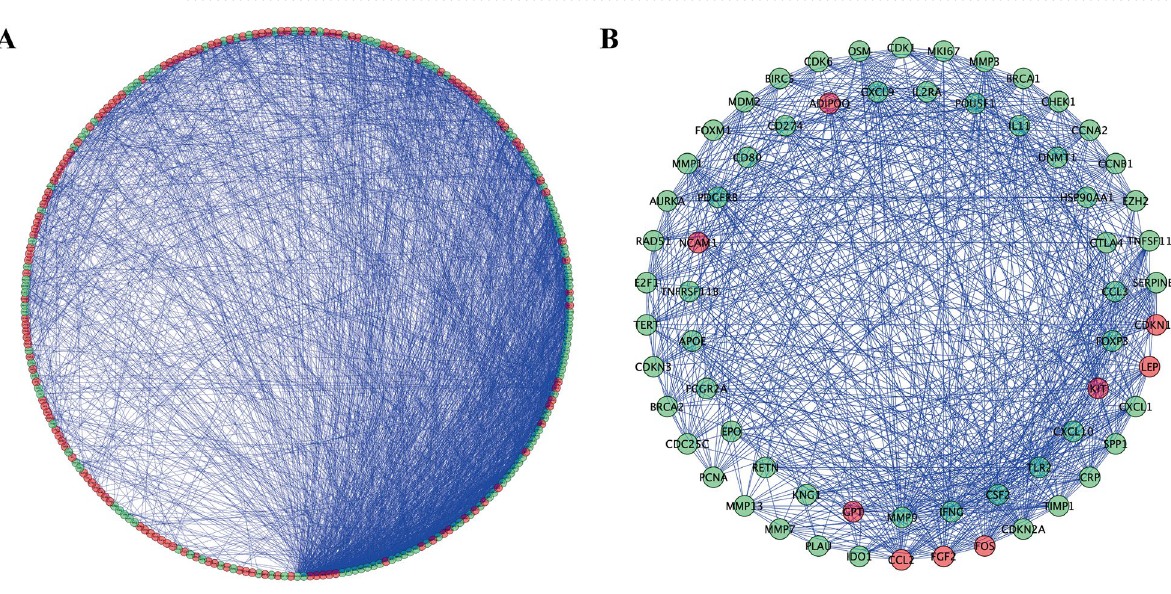
Figure 5. PPI network and modules screening. ( A ) PPI network of differentially expressed OS genes; ( B ) Top 2 critical modules from PPI network. Green circles represent down-regulated genes, and red circles represent up-regulated